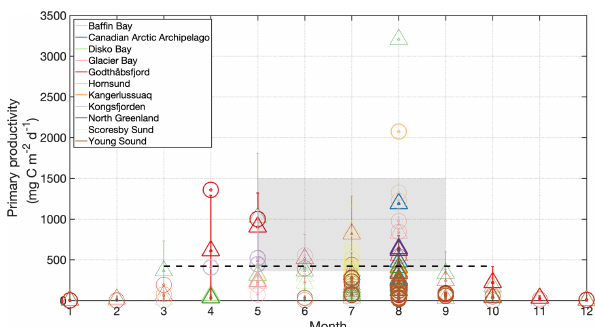
Figure 2. Primary production for Arctic glacier fjord systems in- cluding Disko Bay (Andersen, 1977; Nielsen and Hansen, 1995; Jensen et al., 1999; Nielsen, 1999; Levinsen and Nielsen, 2002), Godthåbsfjord (Juul-Pedersen et al., 2015; Meire et al., 2017), Kangerlussuaq (Lund-Hansen et al., 2018), Kongsfjorden (Hop et al., 2002; Iversen and Seuthe, 2011; Hodal et al., 2012; van de Poll et al., 2018), Nordvestfjord/Scoresby Sund (Seifert et al., 2019), Hornsund (Smoła et al., 2017), Young Sound (Rysgaard et al., 1999; Meire et al., 2017; Holding et al., 2019), the Canadian Arc- tic Archipelago (Harrison et al., 1982) and Glacier Bay (Reis- dorph and Mathis, 2015). Circles represent glacier fjords, trian- gles are sites beyond glacier fjords and bold markers are < 80km from a marine-terminating glacier. Error bars are standard devia- tions for stations where multiple measurements were made at the same station. Dashed line is the pan-Arctic mean primary produc- tion (March–September). Shaded area is the pan-Arctic shelf range of primary production for May–August (Pabi et al.,